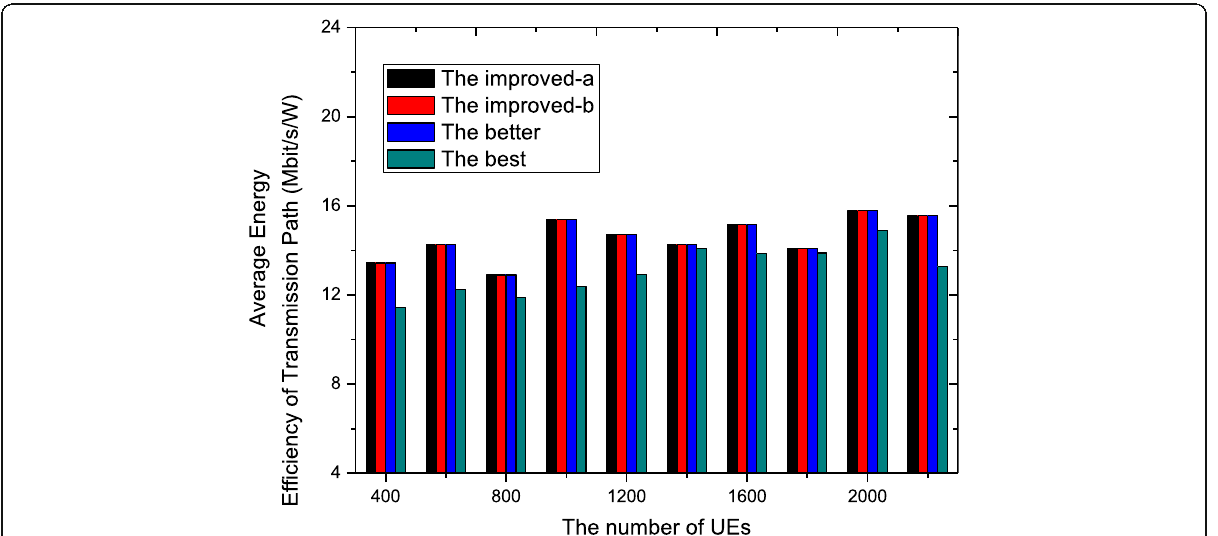
Fig. 12 Comparison of energy efficiency: variation trend of energy efficiency of TOM-PAOD with the number of UEs in the given region, in which the different game decision algorithms are adopted